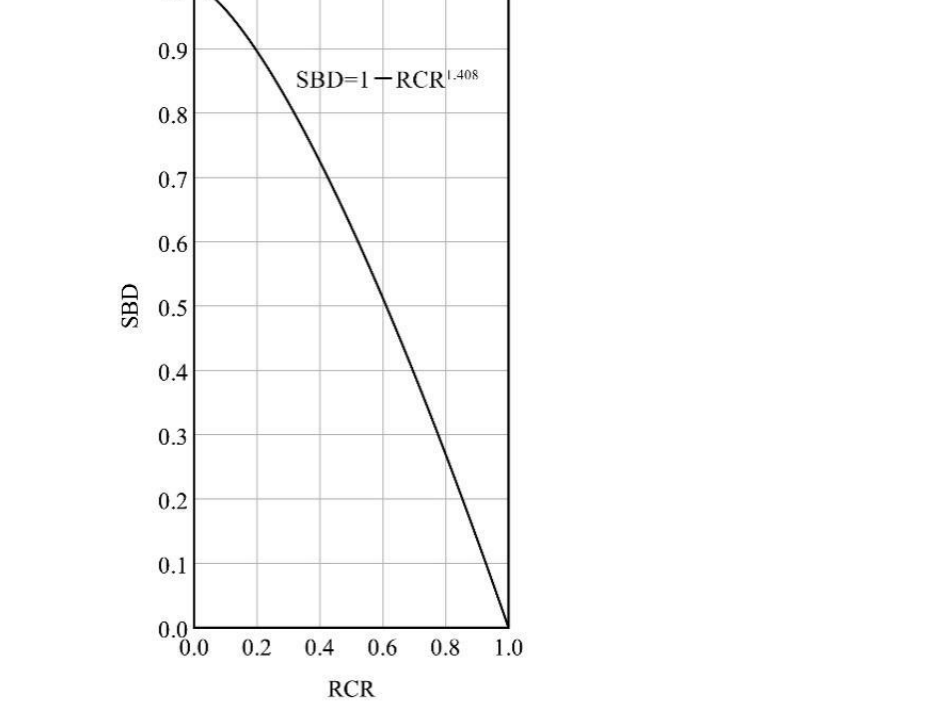
Figure 4. The HDM of canopy biomass. SBD is the standardized biomass density; and RCR is the relative crown radius.